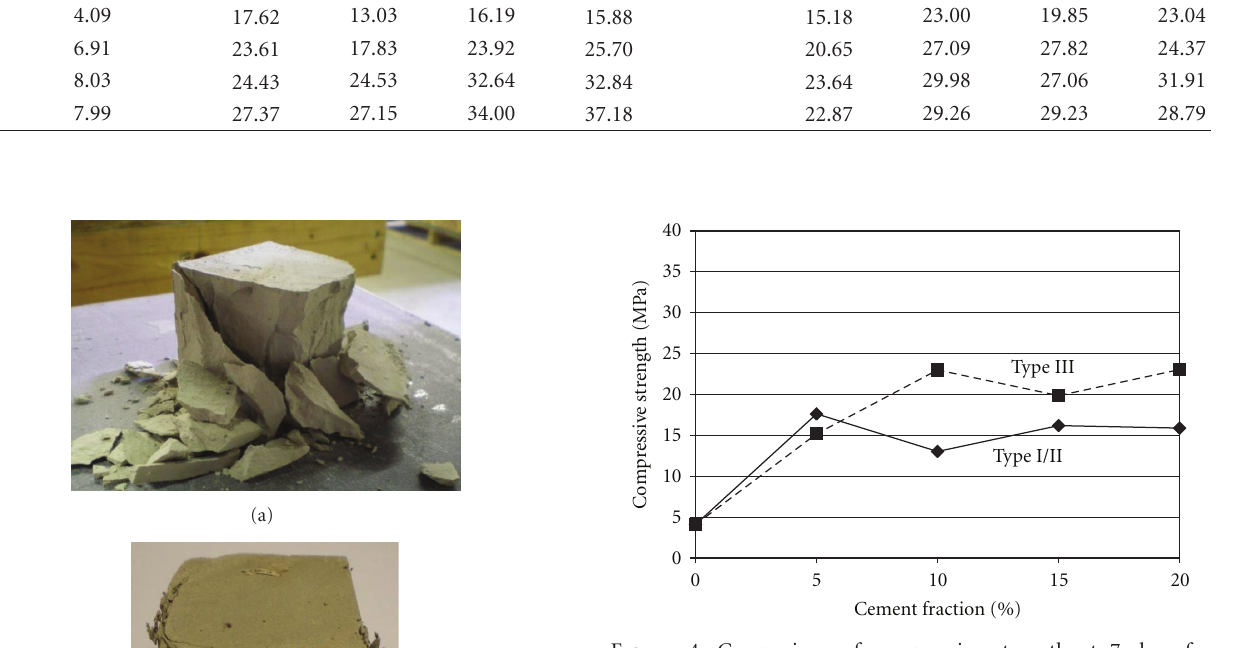
Figure 4: Comparison of compressive strength at 7 days for mixtures with type I/II and type III